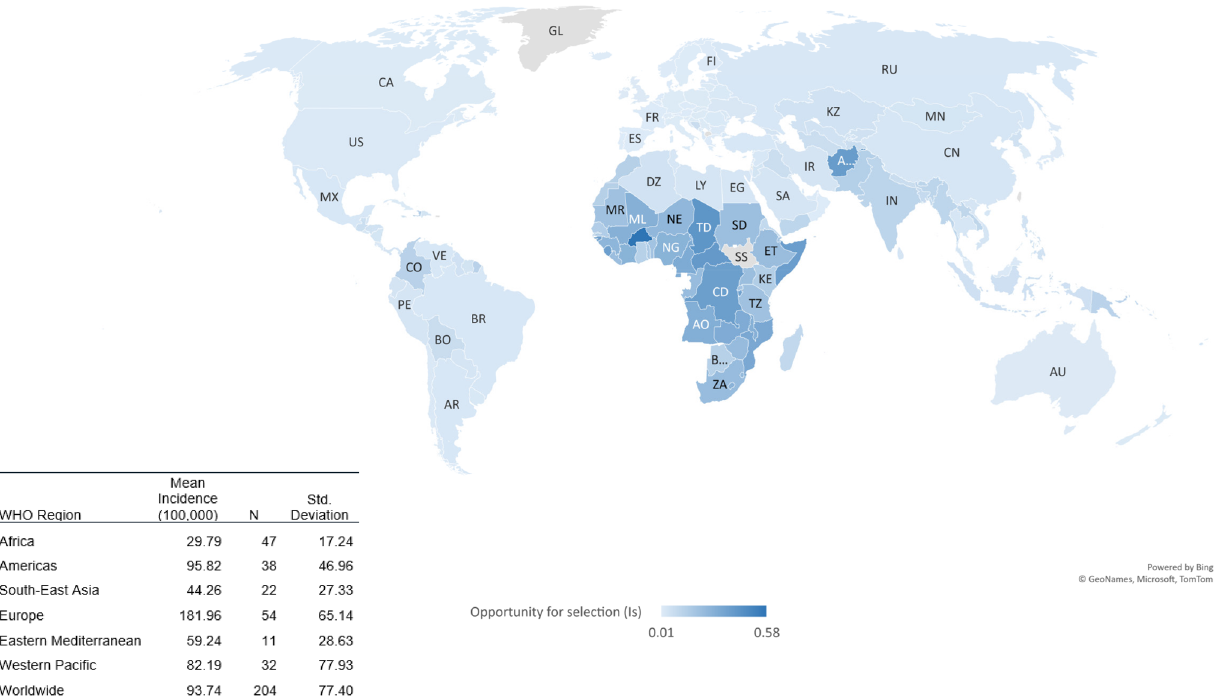
Figure 1. The magnitudes of the opportunity for natural selection I s in different